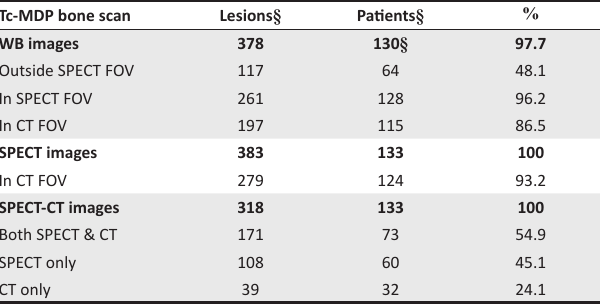
TABLE 1: Lesions detected on 99m Tc-MDP bone